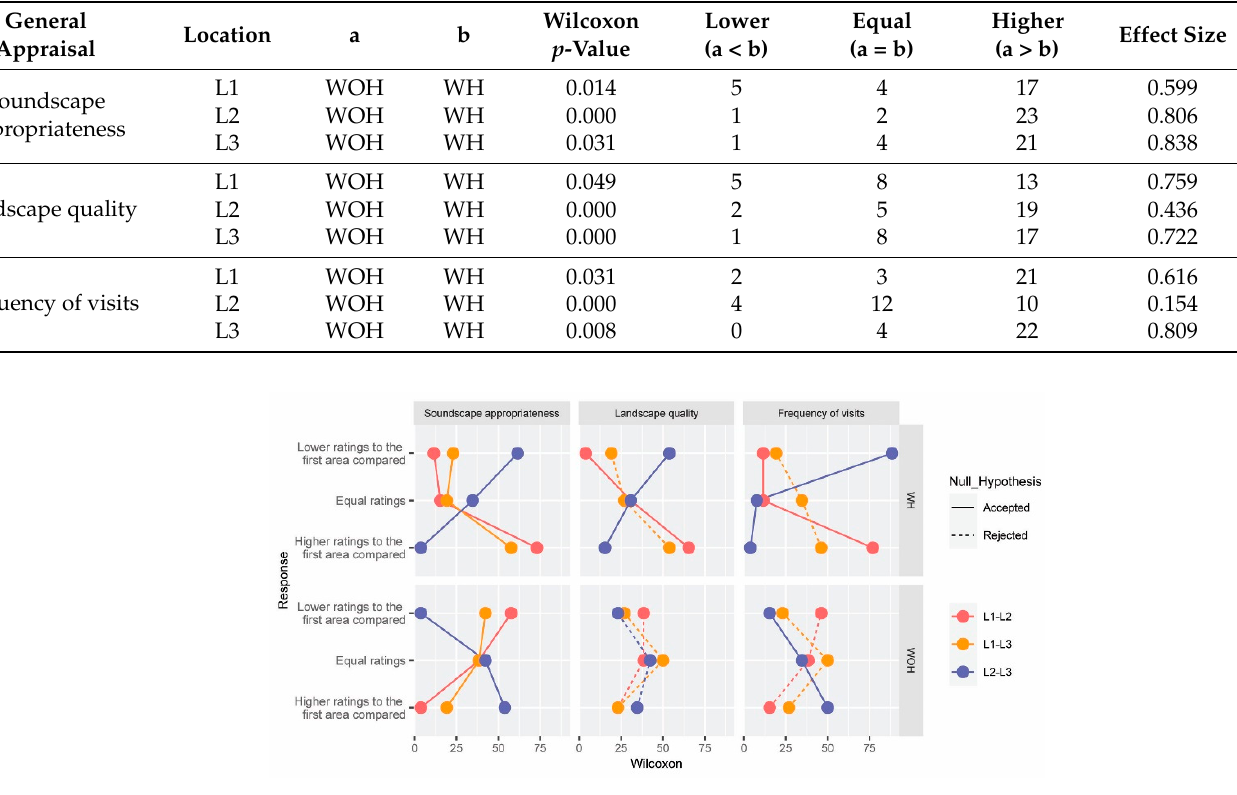
Figure 7. Wilcoxon signed-rank test results for each of the possible combinations of locations—L1–L2 (red), L1–L3 (green), L2–L3 (blue)—on the appraisals given to the soundscape appropriateness, visual quality, and frequency of visits. Results are split by the scenarios with (WH) and without the helicopter noise (WOH). Significant (continuous line) and non-significant differences (dashed line) between paired variables are also represented.